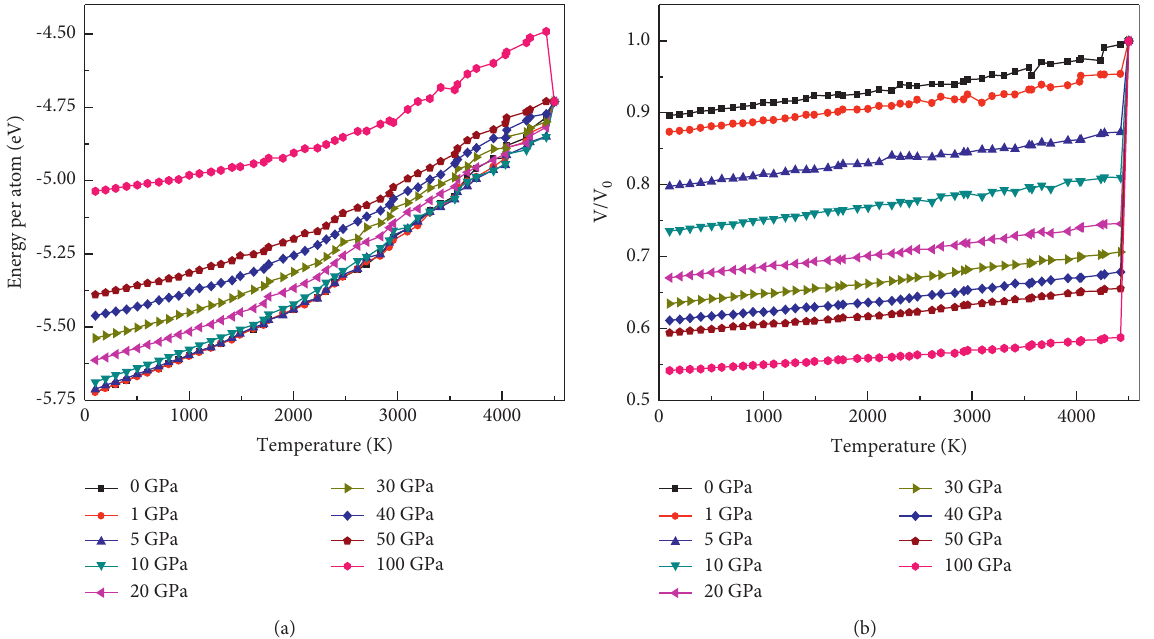
Figure 1: Average energy and volume ratio of atoms as functions of temperature during rapid solidification of SiC under different pressures.